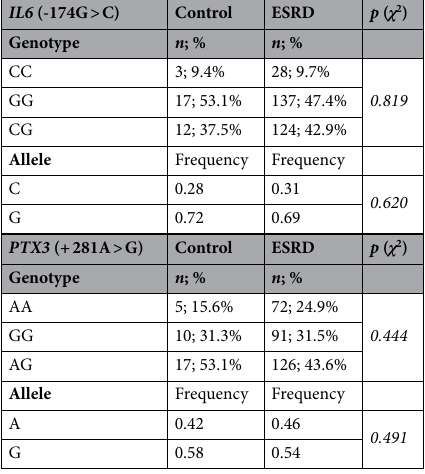
Table 3. Genotype and allelic distribution of IL6 (-174G > C) and PTX3 (+ 281A > G) polymorphisms in controls ( n = 32) and end-stage renal disease patients on dialysis ( n = 289). χ 2 Pearson’s Chi-square test, ESRD end-stage renal disease, IL6 interleukin 6, PTX3 pentraxin 3. Italic denotes p-